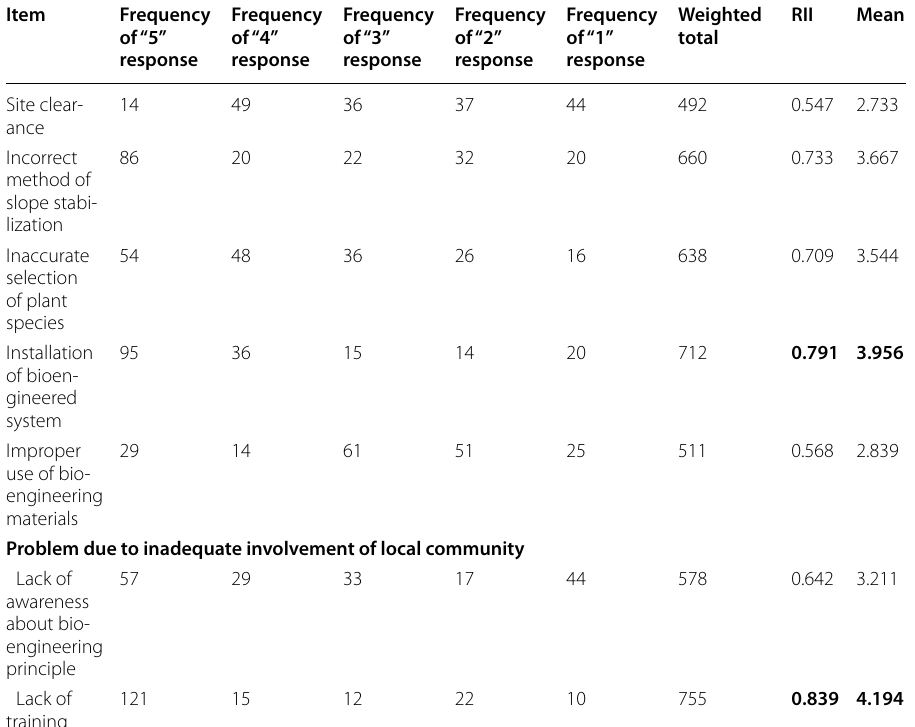
Table 3 Problems during construction work ( n